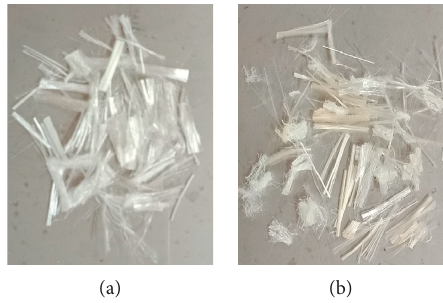
Figure 4: The appearance of polyester fiber with 200 ° C high temperature treatment. (a) Before 200 ° C high temperature treat- ment. (b) After 200 ° C high temperature treatment.